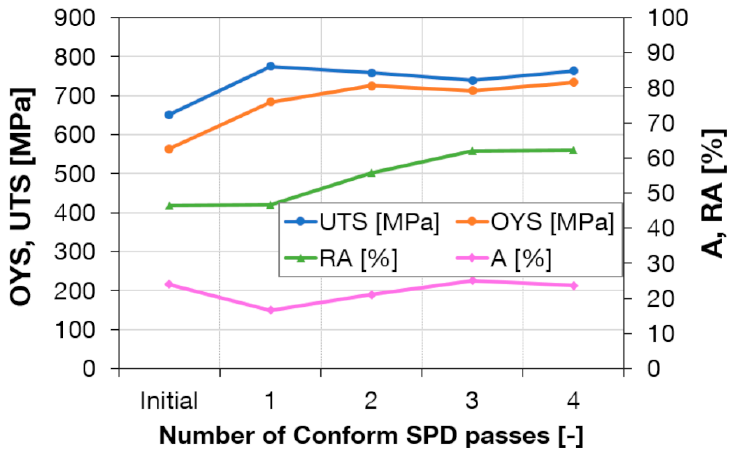
Figure 9. Mechanical properties vs. number of passes through the Conform SPD machine.